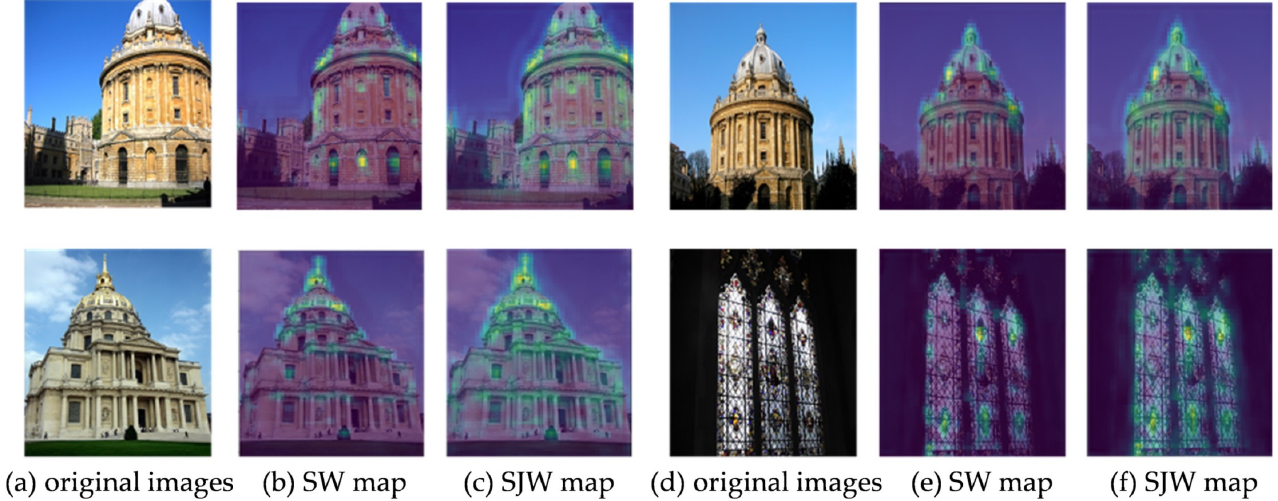
Figure 6. Saliency joint-weighted comparison heat map. SW, saliency